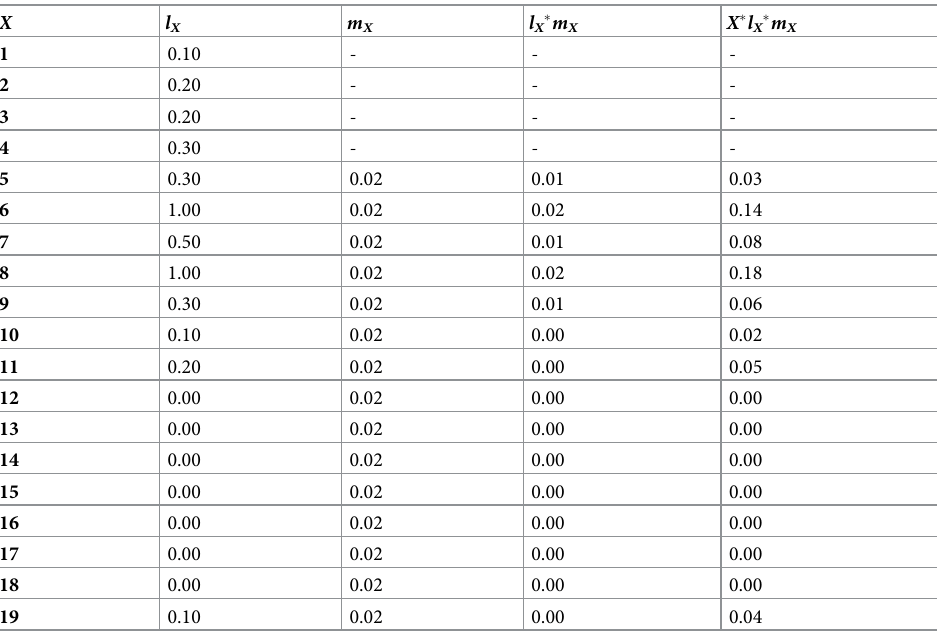
Table 6. Fertility table of P . flavus LM